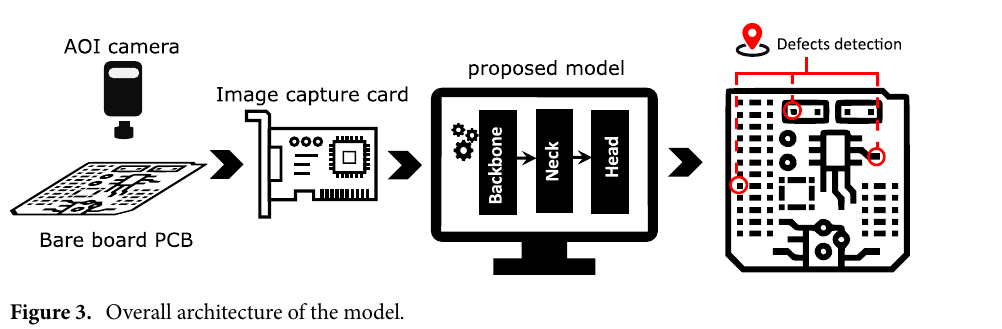
Figure 3. Overall architecture of the